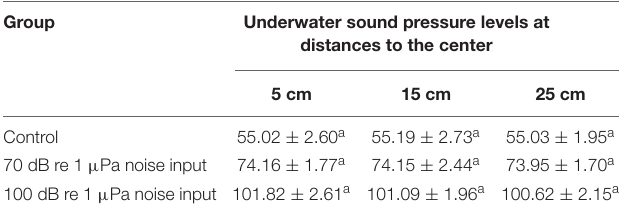
TABLE 2 | The underwater sound pressure levels (dB re 1 µ Pa) near the bottom of the circular bucket at 5, 15, and 25 cm away from the center of the concentric circle vertically below the sound source ( n = 10 per distance, mean ±